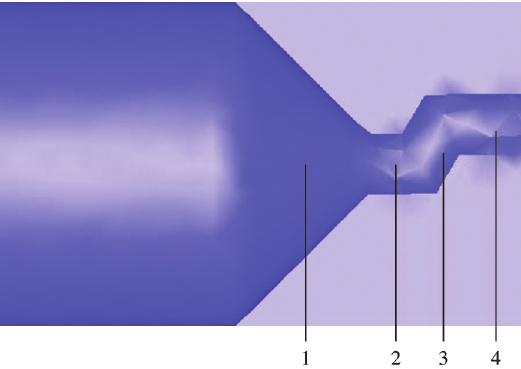
Figure 4. Schematic diagram of ES die with two 120° corner angles and extrusion ratio 32: 1-the reducing zone; 2- the sizing zone; 3-the first shearing zone; 4-the second shearing zone.